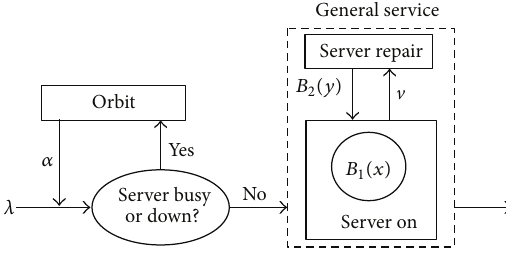
Figure 1: Dynamics of the queueing system.